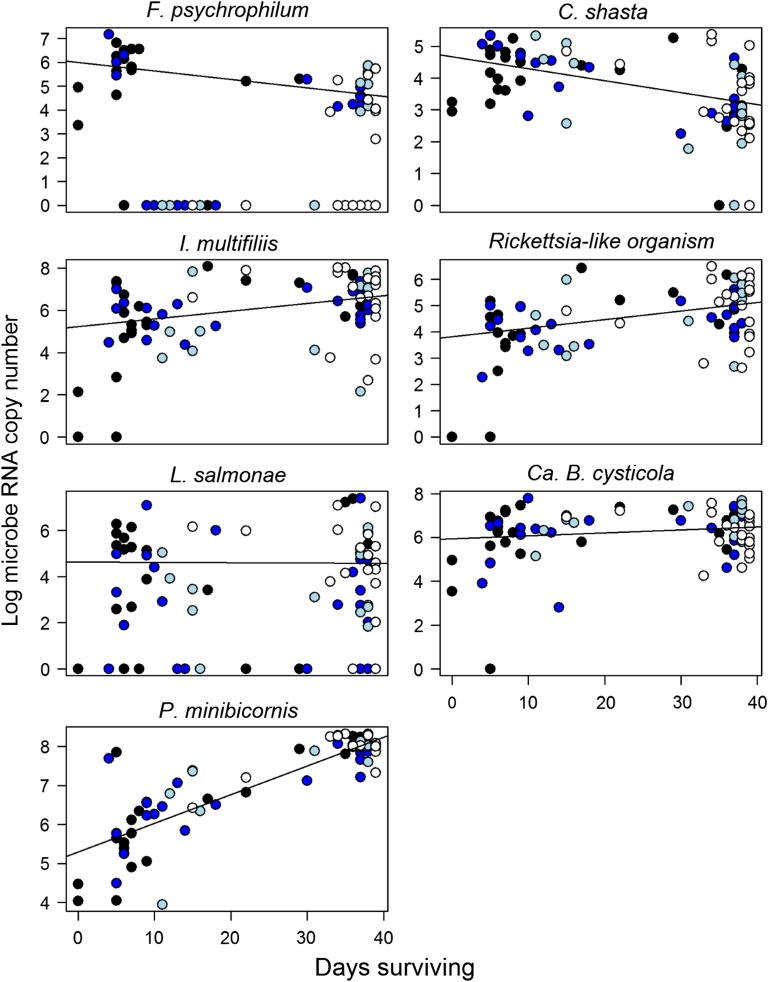
Relative productivity (log RNA copy number) of Flavobacterium psychrophilum, Ceratonova shasta, Ichthyophthirius multifiliis, Rickettsia-like organism, Loma salmonae, Candidatus Branchiomonas cysticola and Parvicapsula minibicornis as a function of days surviving for adult Early Stuart sockeye salmon. Each point represents the microbe burden of an individual at death; colour corresponds to treatment, with severe (20 min) entanglement in black, mild entanglement (20 s) in dark blue, biopsied controls in light blue and non-biopsied controls in white. Screening for microbes was conducted using a pool of aqueous phase from seven homogenized tissues including gill, liver, spleen, head kidney, heart, white muscle and brain (alternated every other individual). All relationships (linear models on positive detections) were significant (P < 0.05), except for L. salmonae (P = 0.97); model parameters can be found in the text.